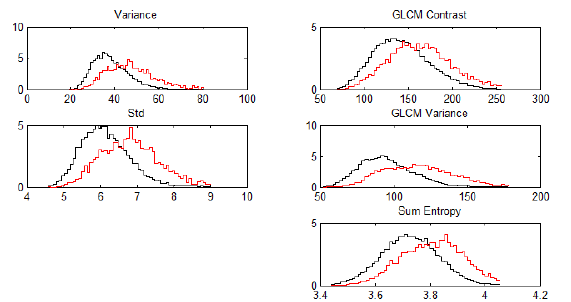
Figure 5. The best performing texture features regarding the discrimination of debris (red) and vegetation (black).